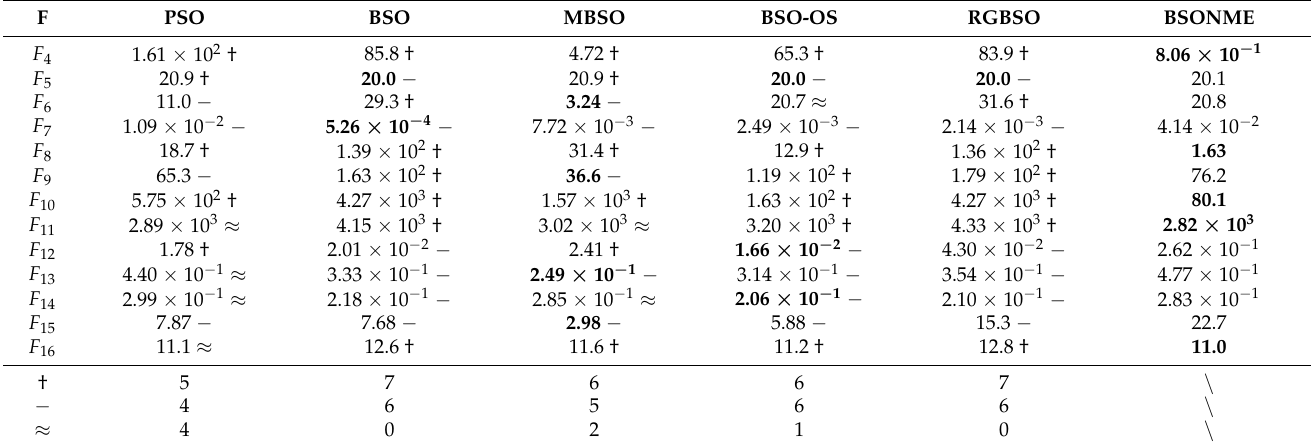
Table 7. Experimental results of PSO, BSO, MBSO, BSO-OS, RGBSO, and BSONME on F 4 – F 16 .